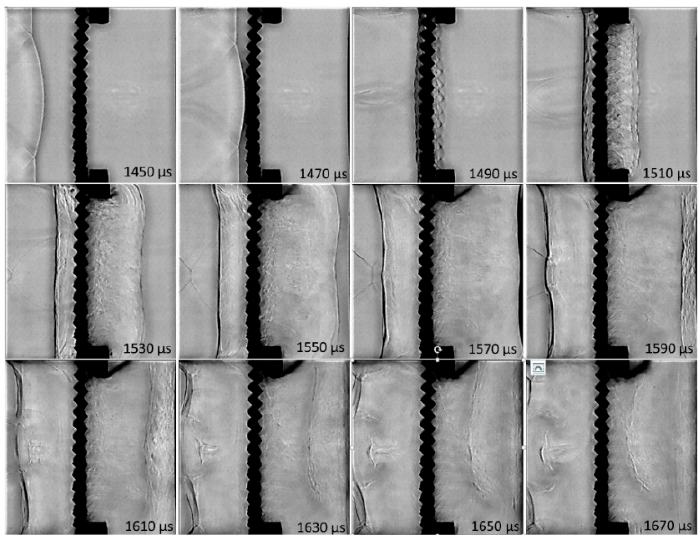
Figure 10. Photographic results of high-speed video recording, showing shock wave propagation through one plate of deployed metal (20 µs between each photograph).